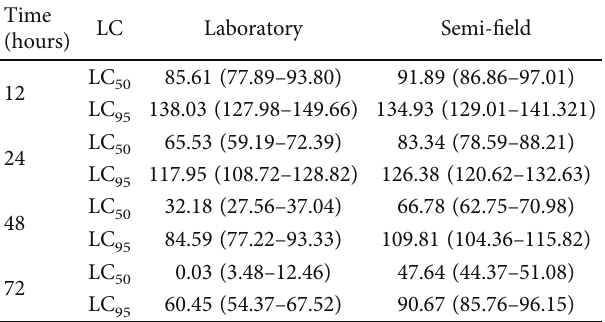
Table 4: Mean lethal dose responses for Anopheles arabiensis